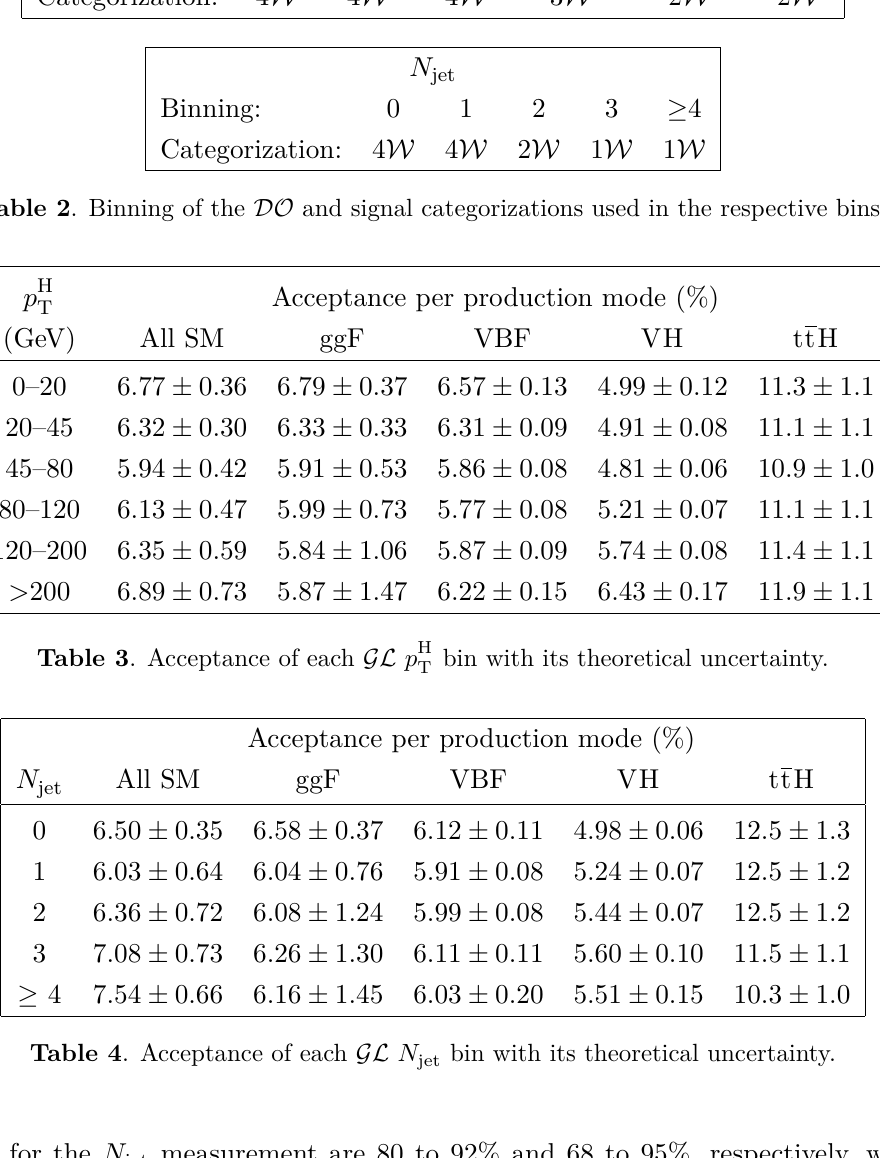
bin with its theoretical jet